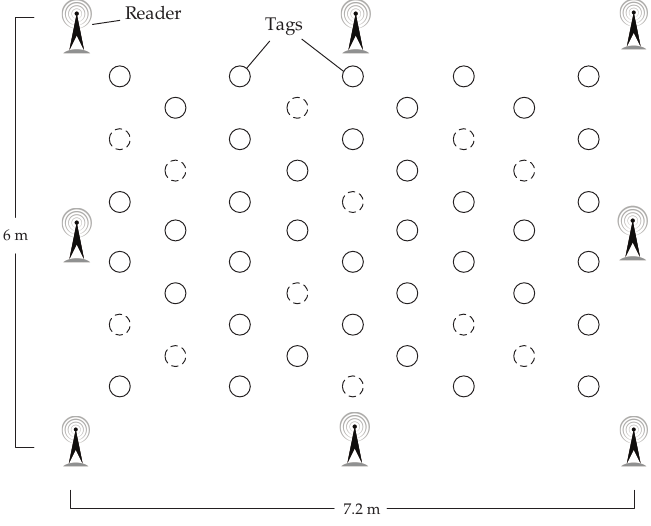
Figure 2. Simulation Experiment